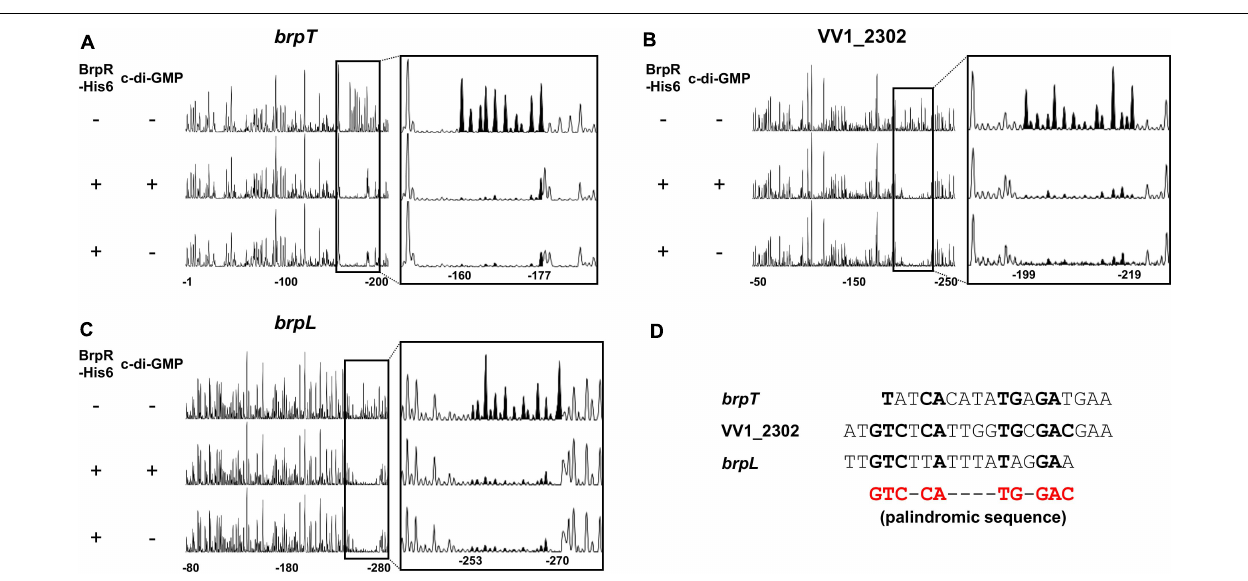
FIGURE 11 | Specific and conserved binding sequences of BrpR-His6. (A–C) The 6-FAM-labeled DNA fragments (40 nM) for the upstream regions of brpT (A) , VV1_2302 (B) , and brpL (C) were incubated with or without BrpR (1 µ M) in the presence or absence of c-di-GMP (50 µ M), and then digested with DNase I. The regions protected from DNase I cleavage by BrpR are expanded on the right panel, and the peaks in the BrpR binding sites are filled black. Nucleotides are numbered relative to the first base of each ORF. (D) The sequences of the BrpR-His6 binding sites are aligned. The palindromic sequence for the BrpR-His6 binding is shown in red below, and the bases that match the palindromic sequence are shown in